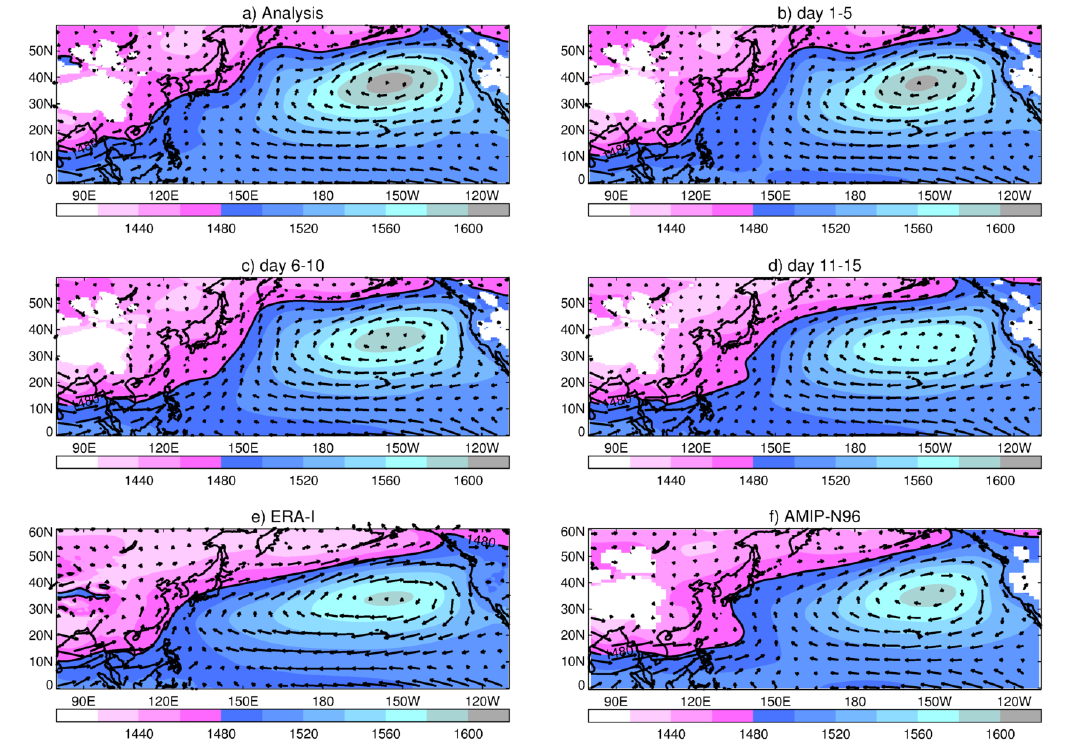
Figure 4. June–August 2016 mean 850 hPa geopotential height and horizontal wind over East Asia and the Pacific regions for ( a ) MetUM analysis and smoothed forecasts at lead times of ( b ) 1–5 days; ( c ) 6–10 days; ( d ) 10–15 days. Climatological June–August mean (1988–2007) is also shown for ( e ) ERA-I and ( f ) AMIP-N96. Geopotential is in metres and wind in ms − 1 . The 1480 contour is shown in